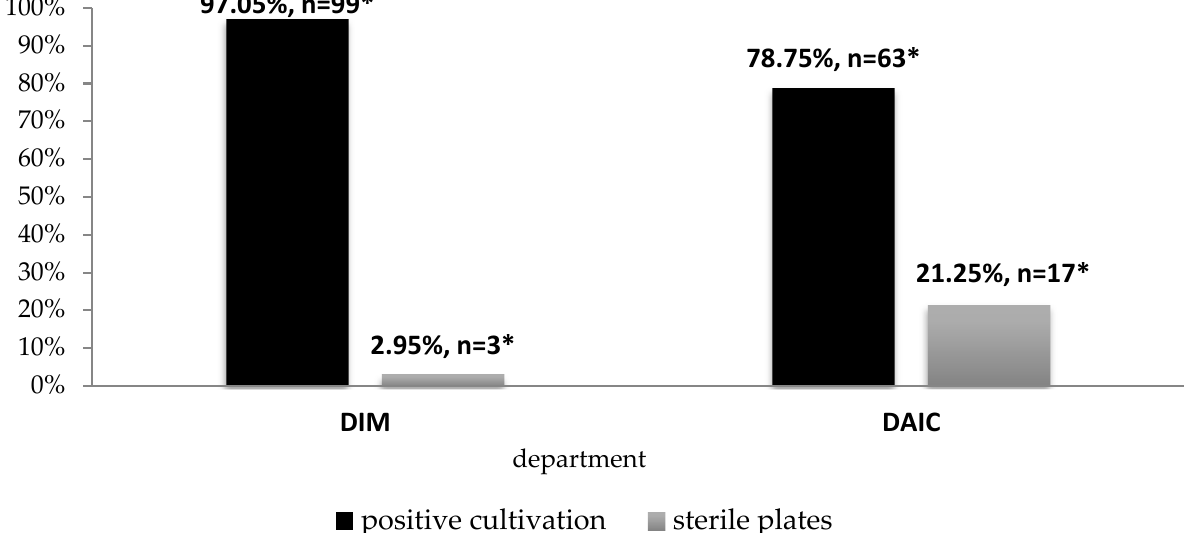
Figure 1. Comparison of the number of sterile plates and positive cultivations on both wards (statistically evaluated by chi-square test) DIM, n = 102; DAIC, n = 80, p = 0.001 (*—significant). Overall, 382 pure bacterial colonies were isolated. All were subsequently subjected to identification on a MALDI-TOF MS, and 377 bacterial cultures (98.7%) were success- fully identified.